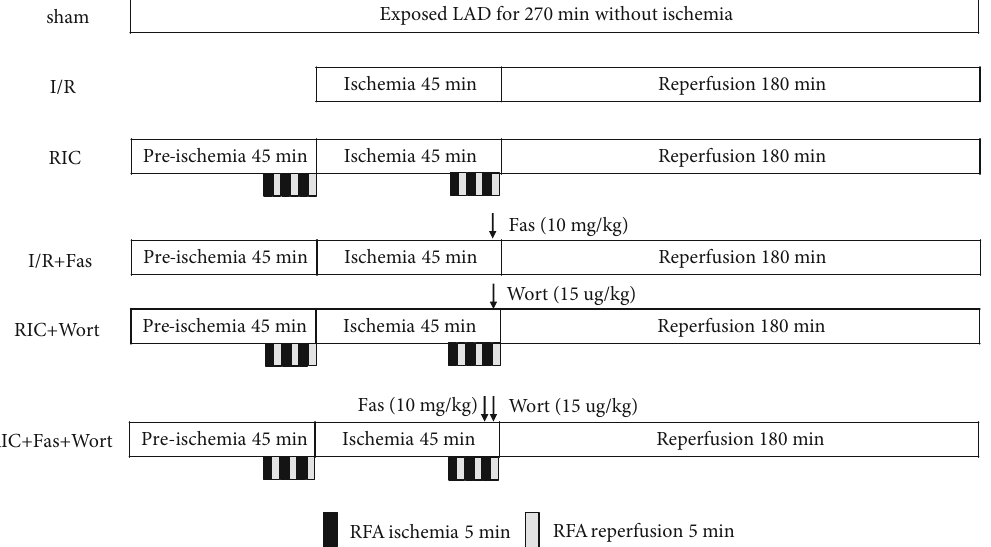
Figure 1: Experiment procedure. LAD: left anterior descending; RFA: right femoral artery; sham: LAD with no other intervention; I/R: ischemia/reperfusion; RIC: remote ischemic conditioning; Fas: fasudil; Wort: